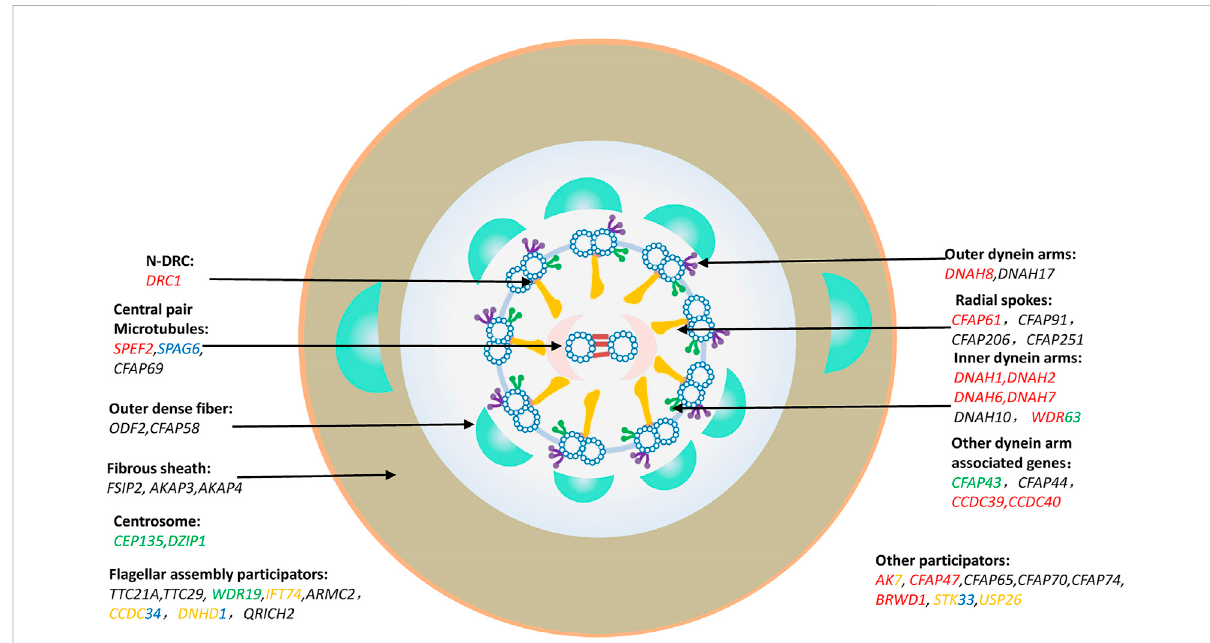
FIGURE 2 MMAF causation genes. Classi fi cation and description of MMAF pathogenic genes by protein-affected structure and mechanisms. Genes marked in red were involved in PCD; Genes marked in green were involved in neurological disorders; Genes marked in blue were involved in tumorigenesis; Genes marked in yellow were involved in rare genetic conditions, such as spondylocostal dysostosis, Joubert Syndrome, Bardet- Biedl Syndrome, Tonne-Kalscheuer syndrome, etc. Genesmarked in multiple colors indicated that themutations in them mightcausemultiple diseases, which were presented in different colors described above,